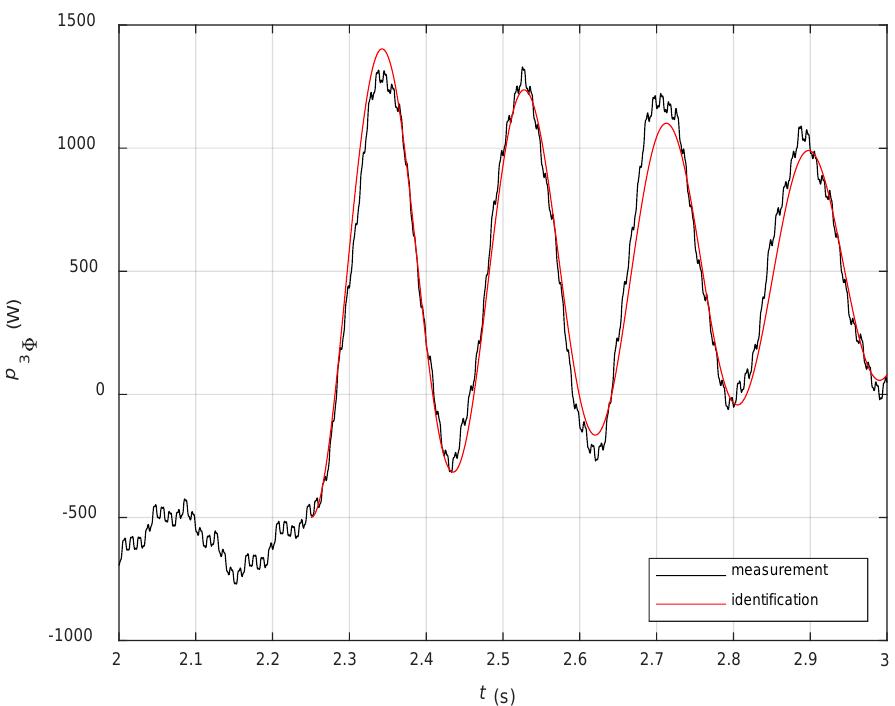
Figure 22. Time response of the instantaneous three-phase power of the laboratory synchronous generator S n = 12 kV in the vicinity of the operating point P = 0 kW, Q = 12.0 kVAr on the step change of mechanical torque corresponding to mechanical power change from − 0.5 kW to 0.5 kW compared with the identified local oscillation.